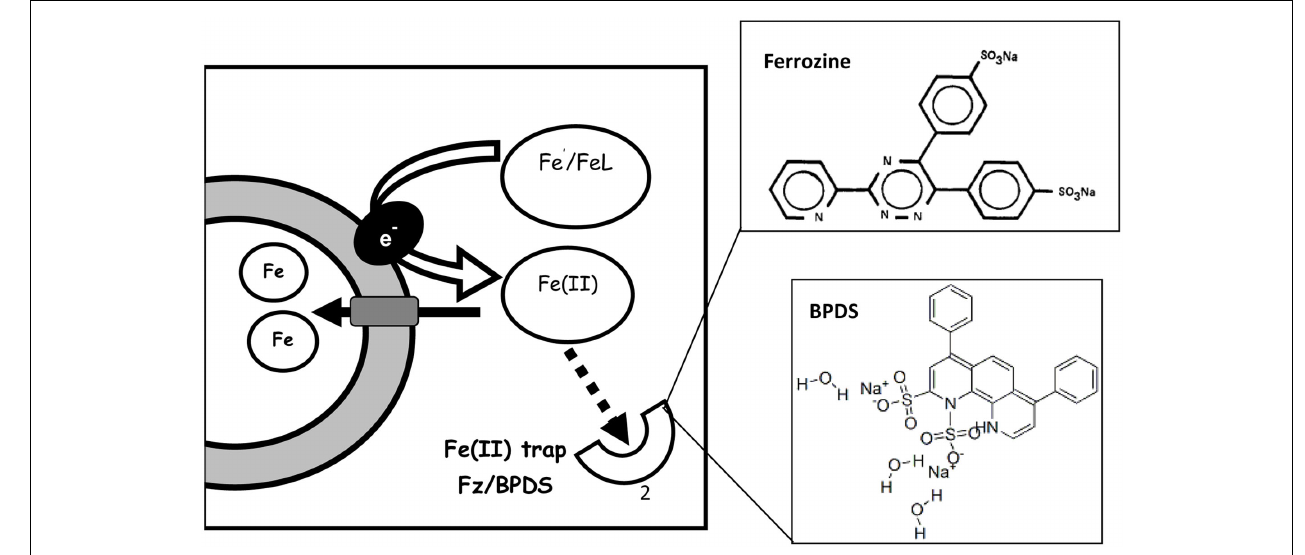
FIGUREA1 |Trapping of ferrous iron formed during Fe (cid:2) reduction with ferrozine (Fz) or Bathophenanthrolinedisulfonic acid (BPDS). The Fe(II) trap competes with cells over ferrous iron formed during cell-mediated Fe reduction.The structures of two such traps – ferrozine and BPDS – are shown